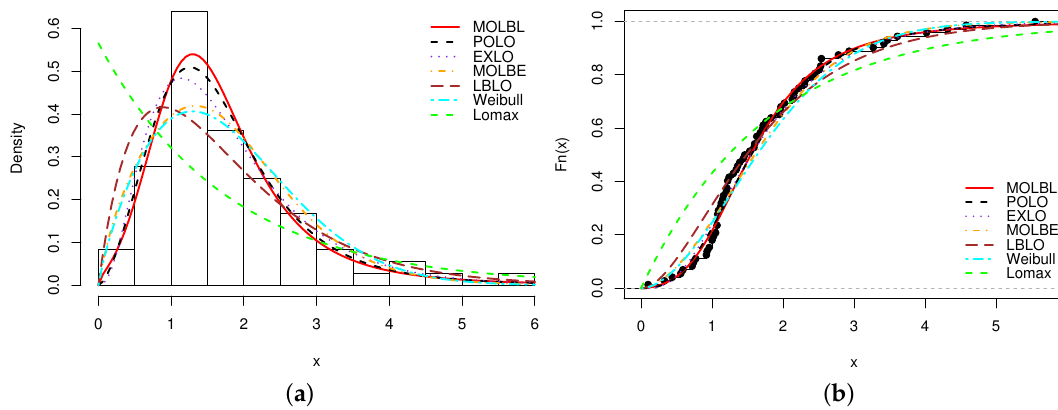
Figure 3. Plots of ( a ) estimated pdf and ( b ) estimated cdf of the MOLBL model with those of the other competitive models for Data set 3.